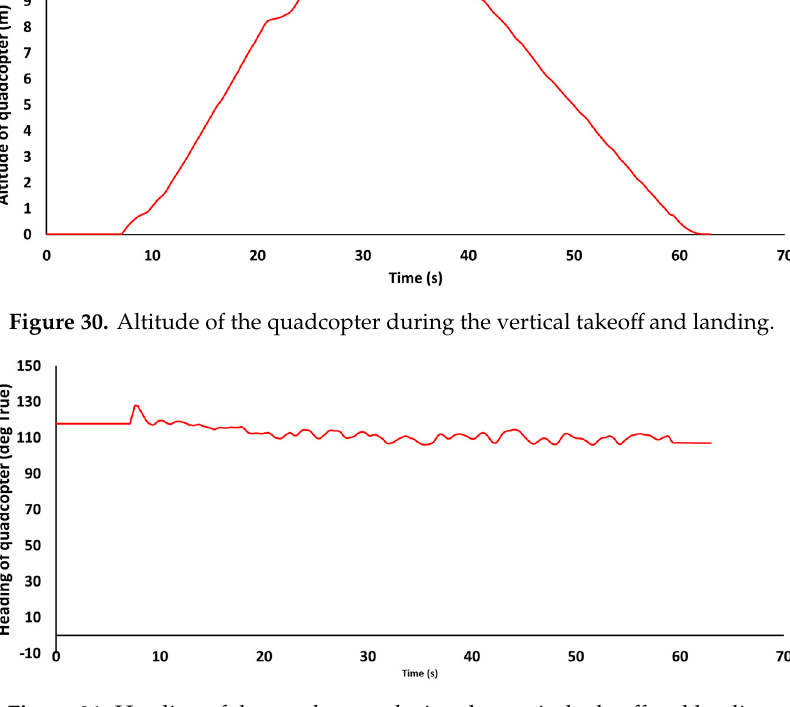
Figure 31. Heading of the quadcopter during the vertical takeoff and landing.